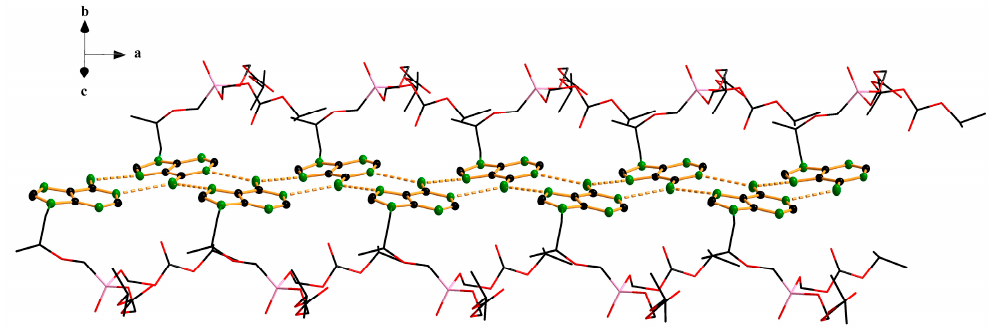
Figure 4. View of a linear chain along the a -axis connected via intermolecular hydrogen bonds between the nitrogen atoms of the purine rings.